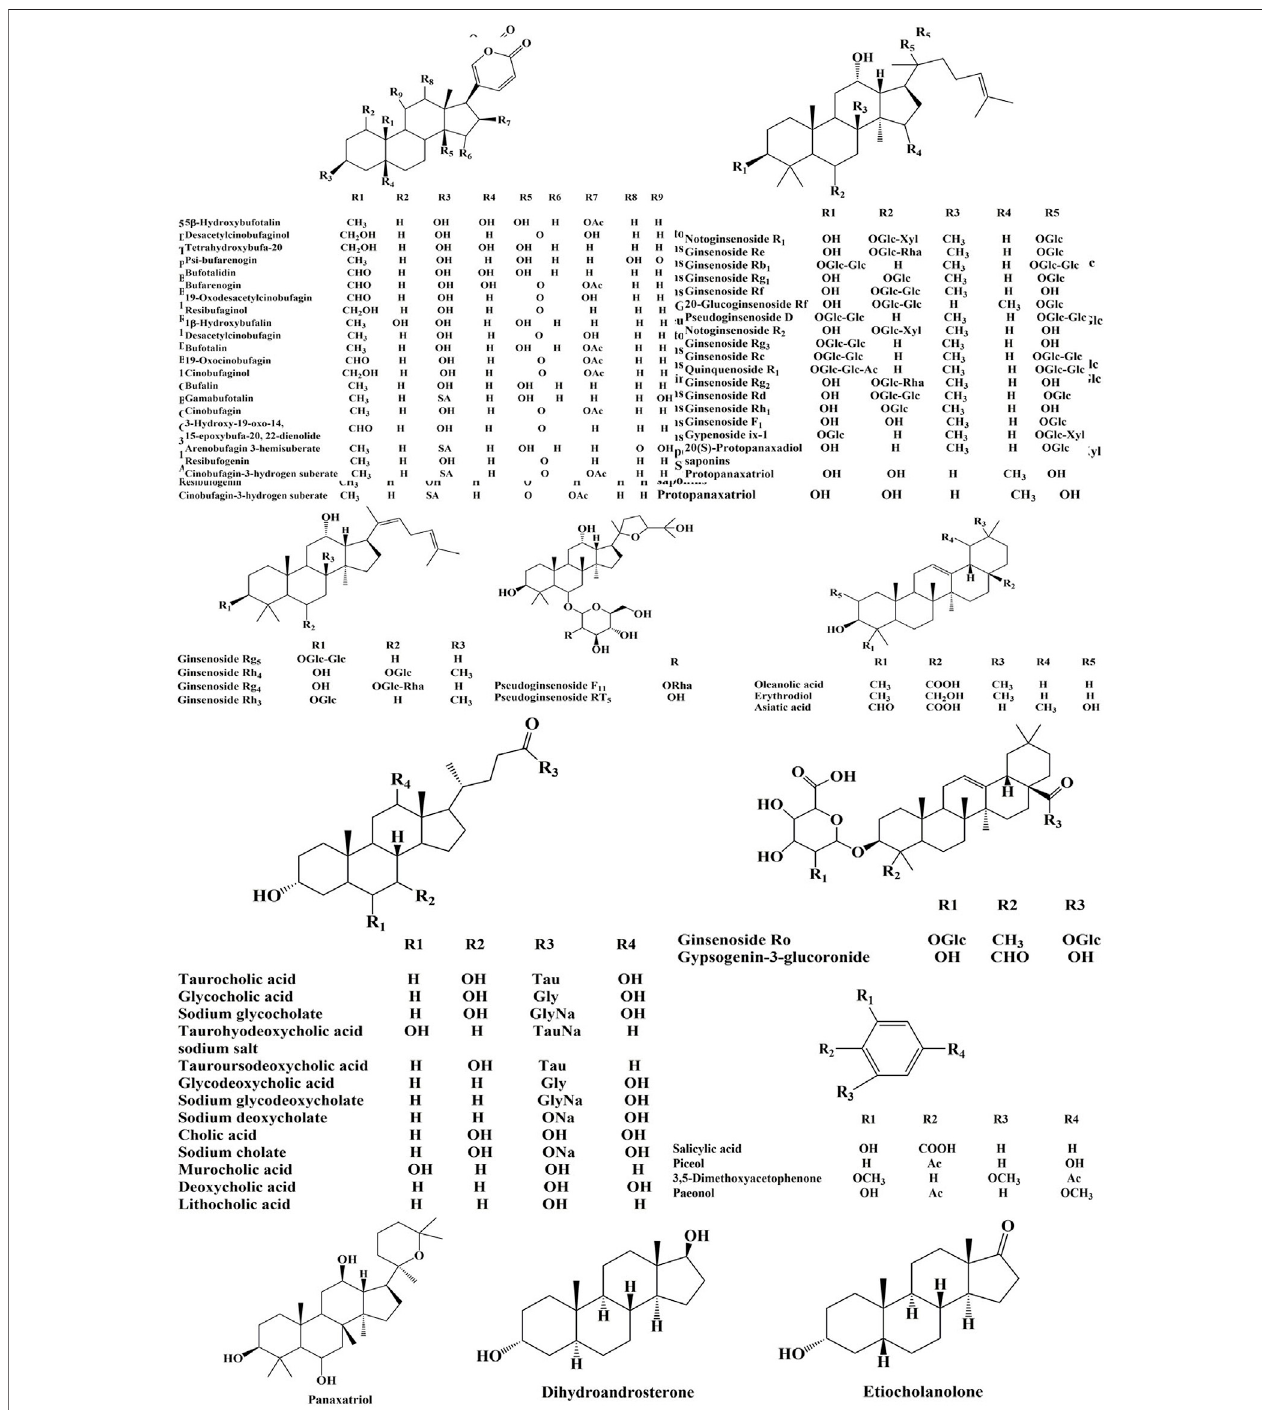
FIGURE 2 | Chemical structures of compounds identi fi ed in